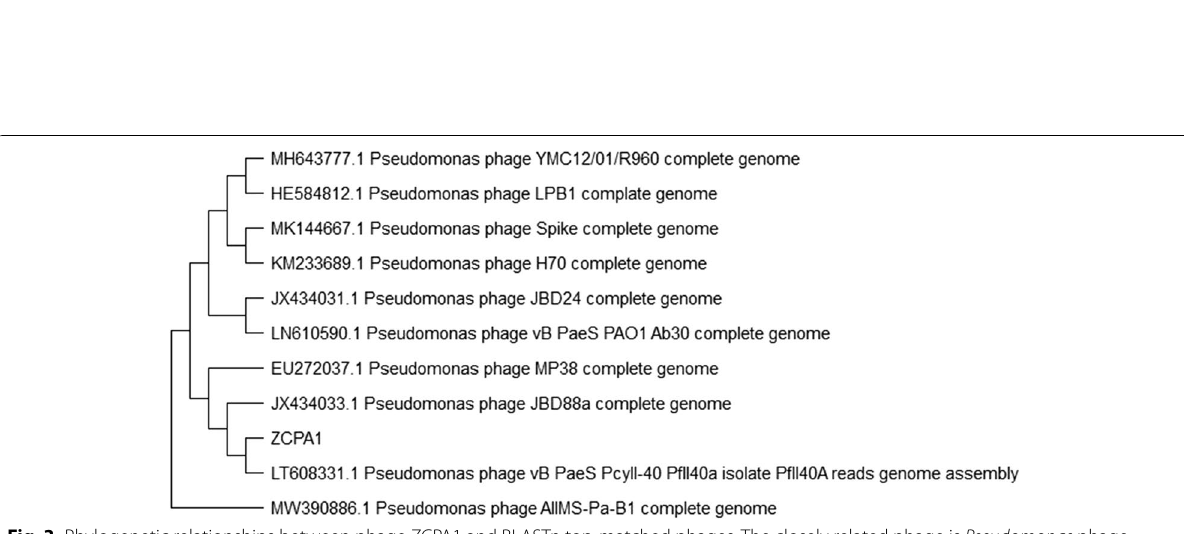
Fig. 3 Phylogenetic relationships between phage ZCPA1 and BLASTn top‑matched phages. The closely related phage is Pseudomonas phage vB_PaeS_PcyII‑40_PfII40a isolate genome (GenBank Acc. No.